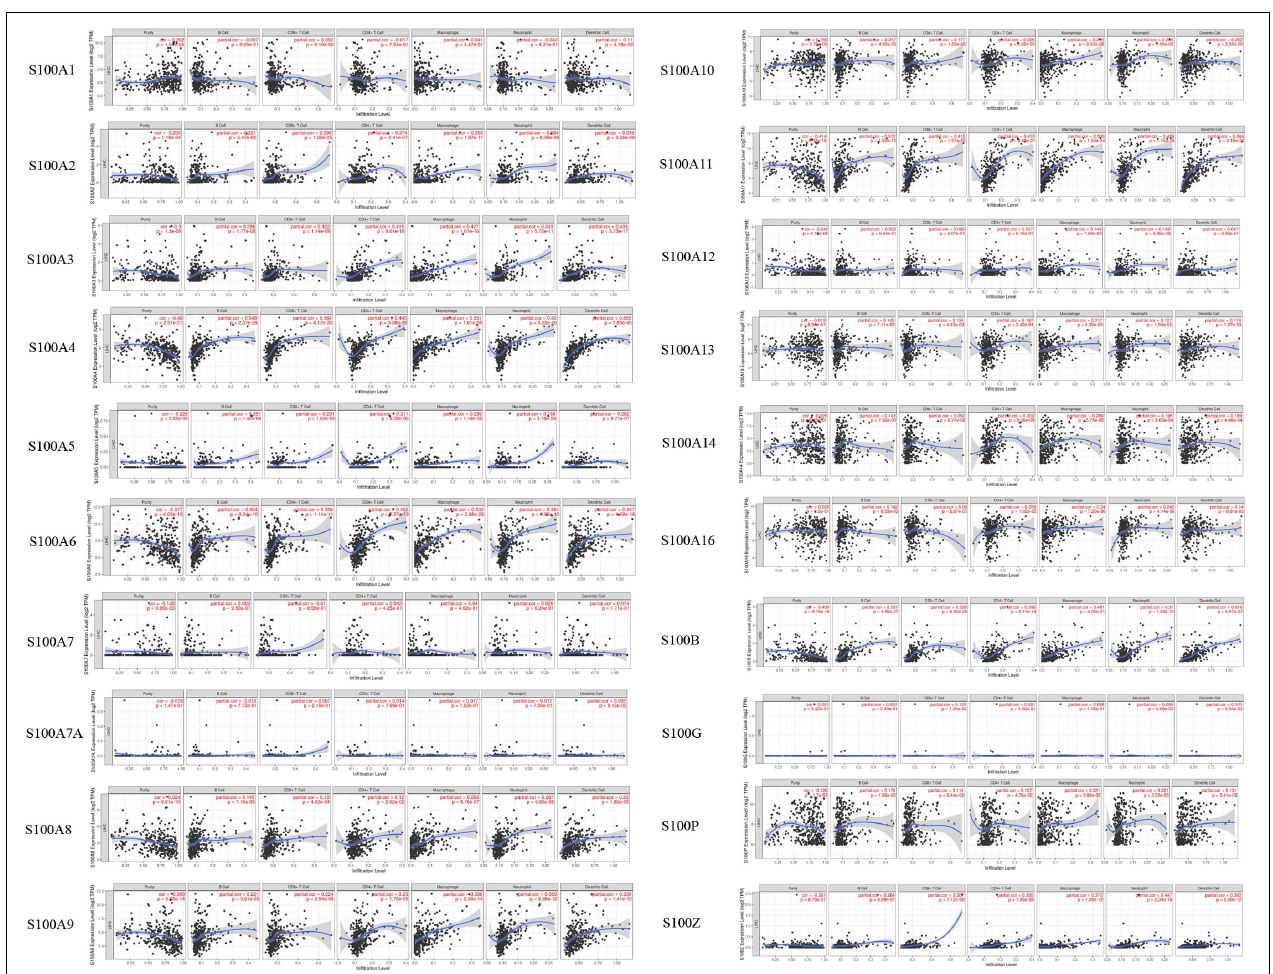
FIGURE 9 | Association of 20 S100s genes with immune infiltration in HCC (TIMER). The expressions of S100A2/S100A3/S100A4/S100A5/S100A6/S100A8/S100A9/S100A10/S100A11/S100A13/S100A14/S100A16/S100B/S100P/S100Z were found to be significantly associated with the immune infiltrating levels of B cells, CD8 + T cells, CD4 + T cells, macrophages, neutrophils, and dendritic cells. A p < 0.05 was considered statistically